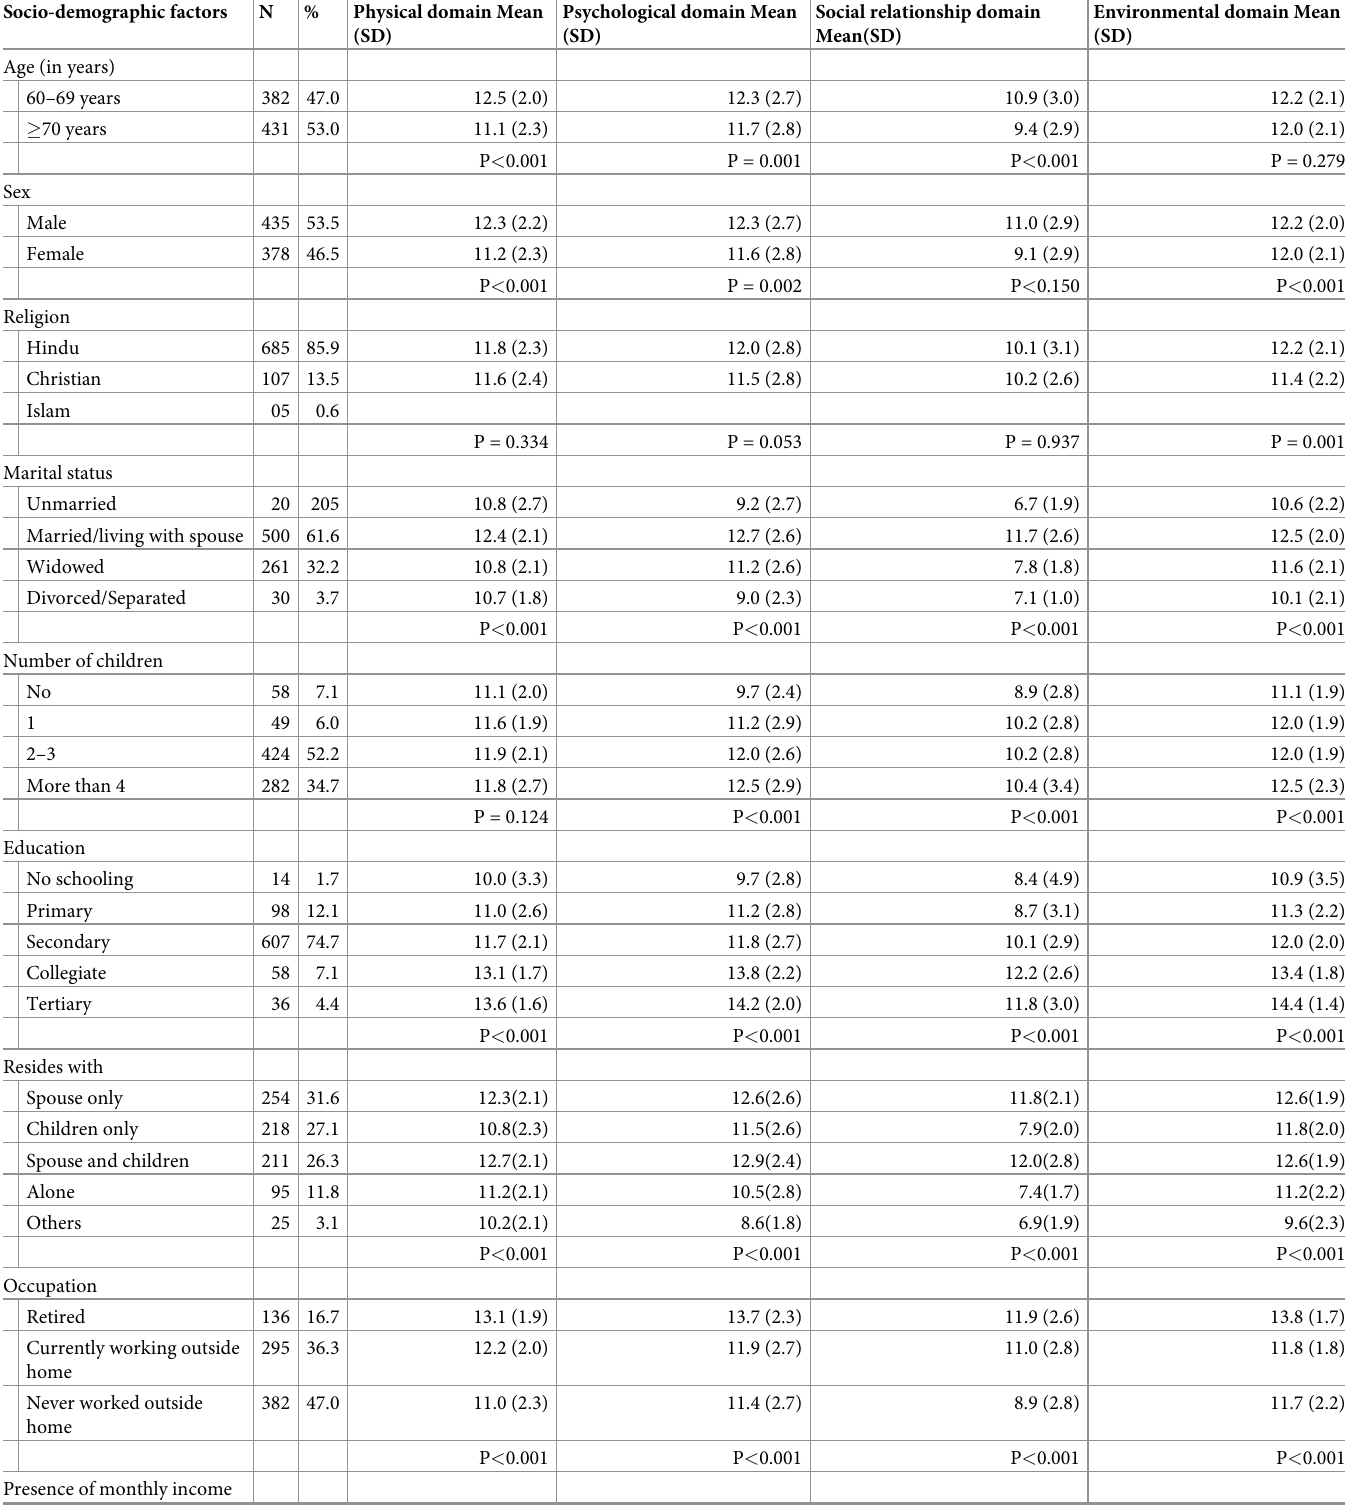
Table 2. Associations of socio–economic characteristics with the four domains of QOL. Socio-demographic